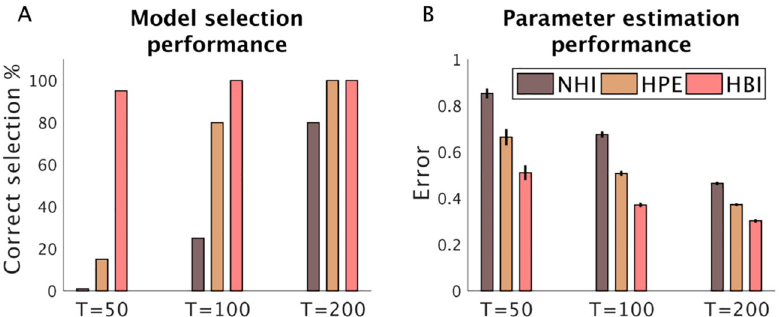
Fig 5. Performance of the HBI as a function of the number of trials. 10 and 30 artificial subjects were generated according to the RL and dual- α RL models, respectively. These simulations were performed with a different number of trials (T) per subject. A) The accuracy of model selection by NHI, HPE, and HBI for T = 50, T = 100, and T = 200 trials; B) Mean error in estimating individual parameters across both models and parameters. Note that the estimation errors here are computed on the normally distributed parameters. The estimation error is defined as the absolute difference between estimated parameters and the true parameters. In all plots, error-bars are standard errors of the mean obtained across simulations 20